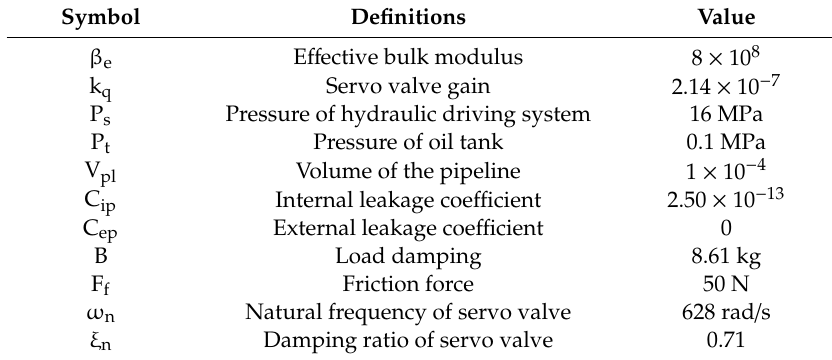
Table 6. The simulation parameters of hydraulic system in MATLAB /